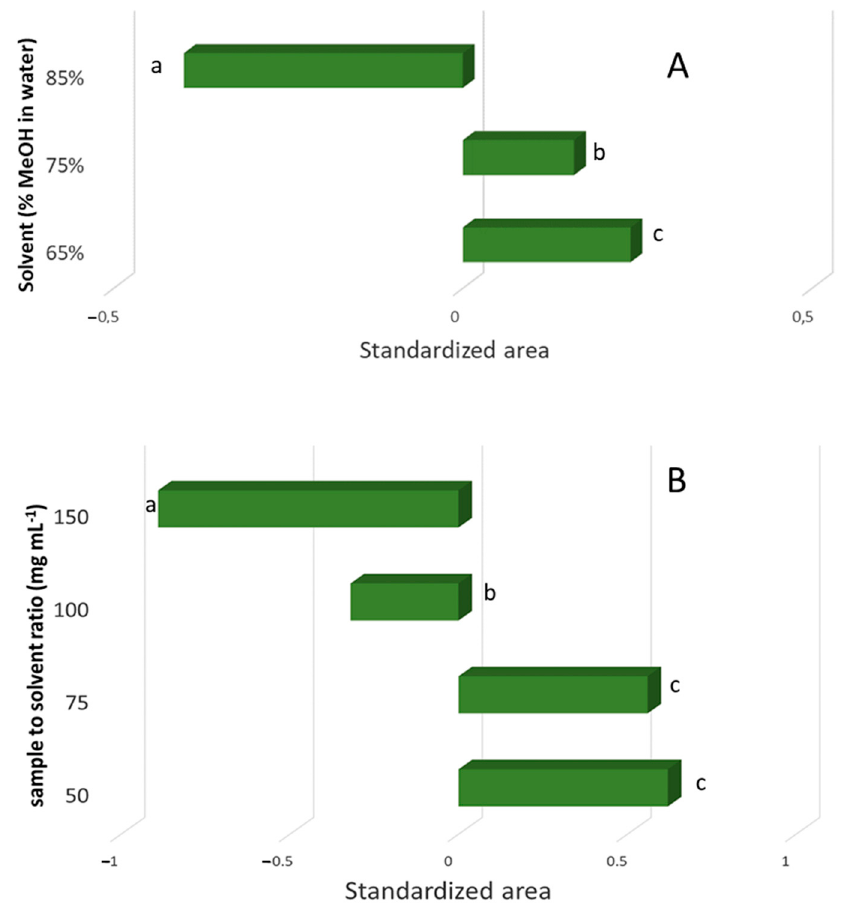
Figure 3. Effect of extraction solvent (percentage of methanol in water) ( A ) and sample to solvent ratio (mg of sample mL − 1 of solvent) ( B ) on the average ( n = 3) standardized recovery of phenolic compounds. Bars with different letters indicate significant differences ( p < 0.05).